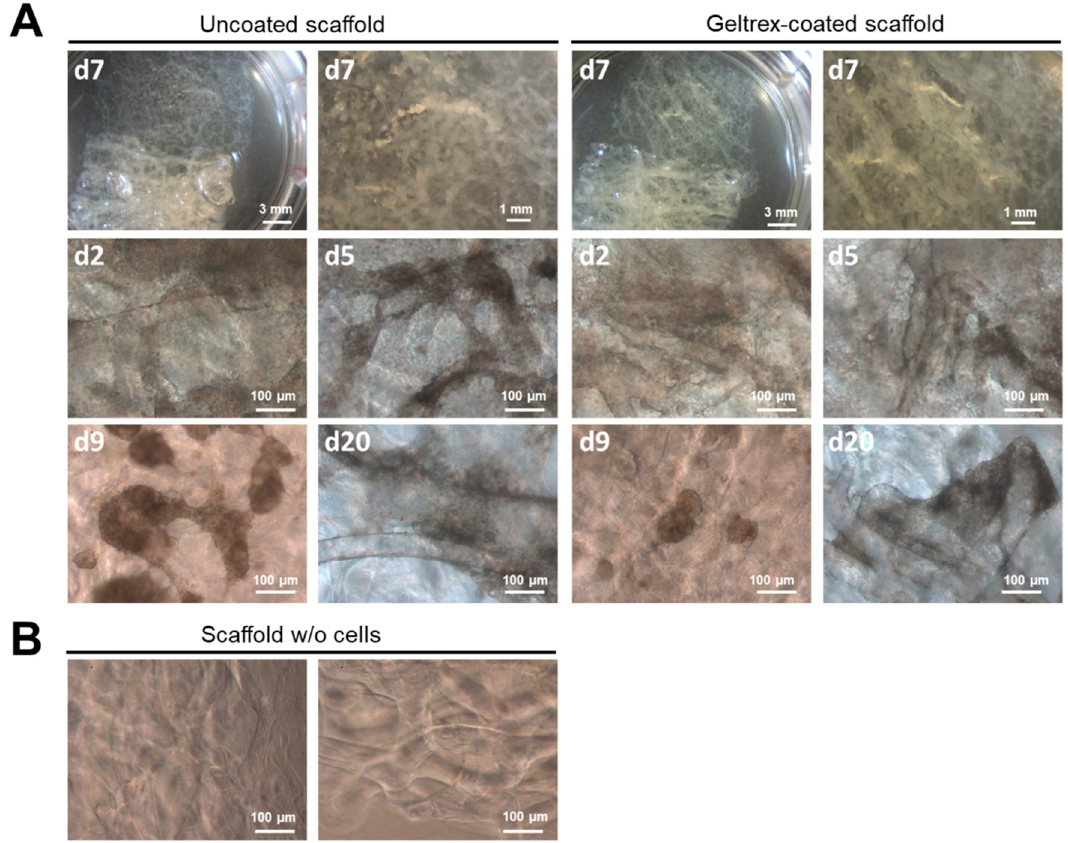
Figure 7. Evaluation of I. labyrinthus structures to culture iPSC-derived cardiomyocytes. ( A ) Schematic image of sponge structures cultured in transwell plates with low medium levels, 8-week-old iPSC-CMs were supplied by medium absorbed by the sponge structure and cultured in uncoated and Geltrex®-coated sponge scaffolds for 20 days. ( B ) Microscopic images of sponge scaffold. iPSC-CMs were visualized using phase contrast microscopy. Images from two experiments performed using iPSC-CMs from different healthy donors. See also respective video files in the Supplementary Materials.